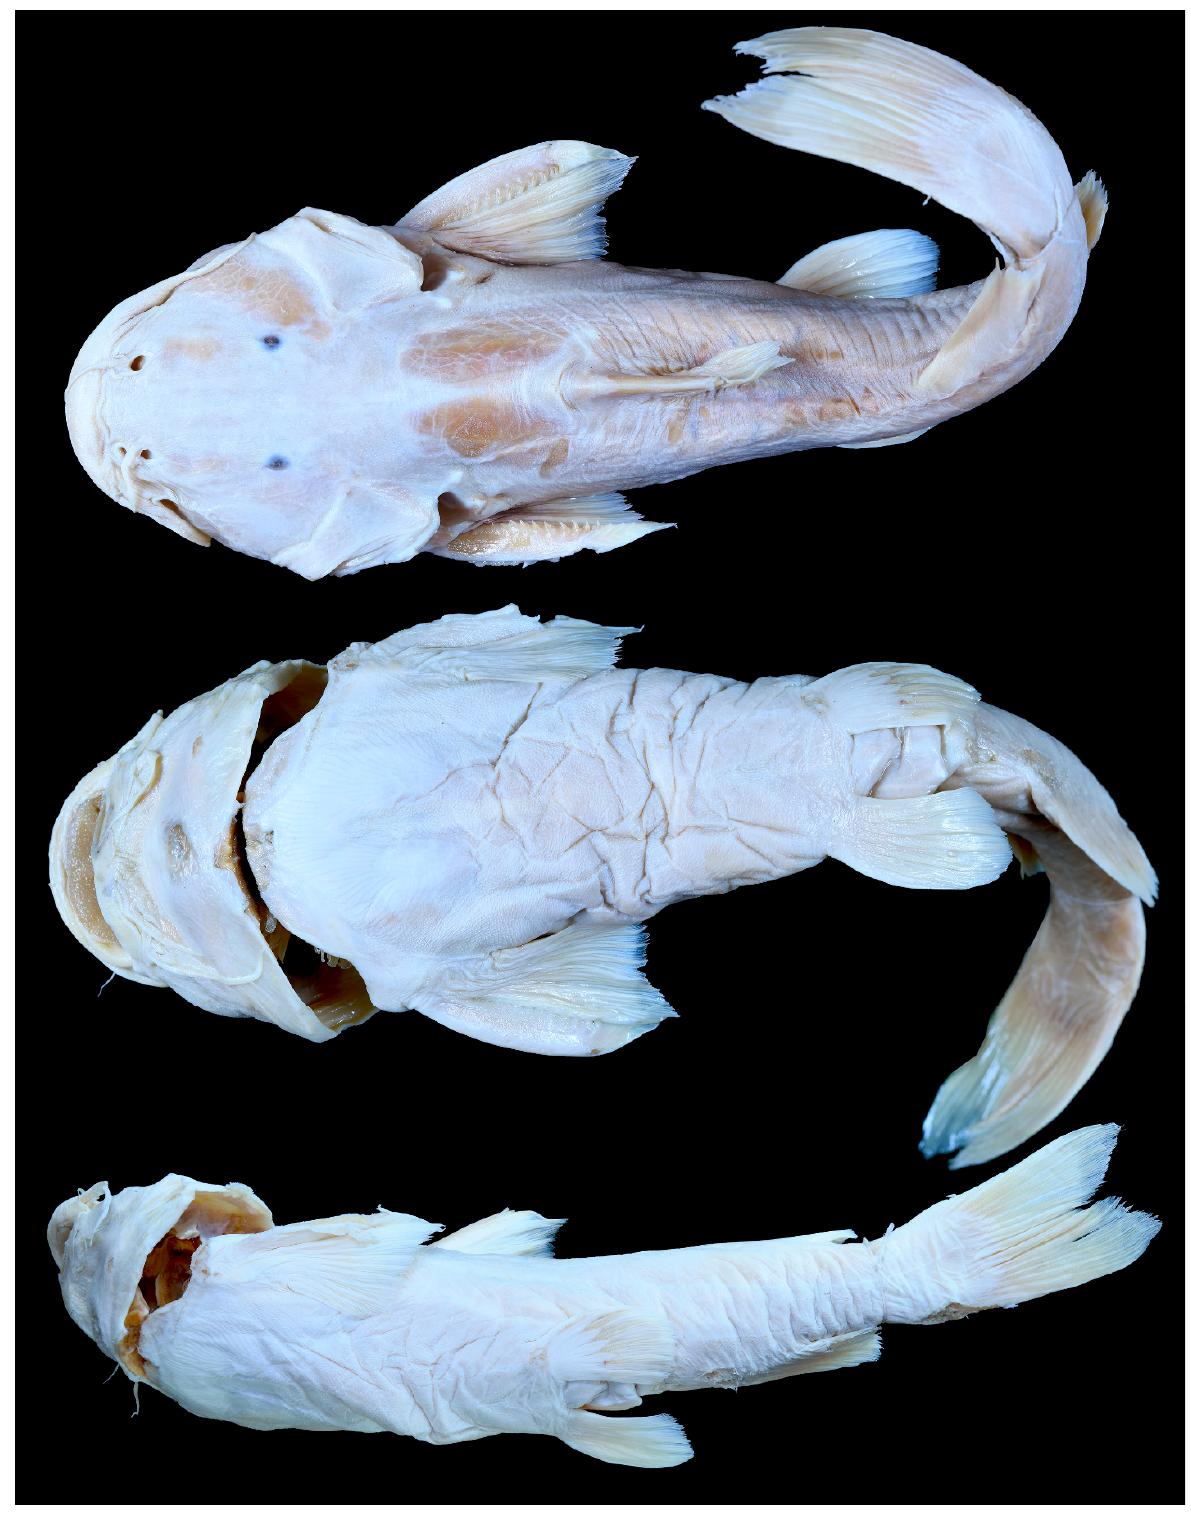
Figure 9. Glyptothorax cous , BMNH 1955.6.25.2, holotype, 243 mm SL; Syria: Qweiq at Aleppo. Copy right: The Trustees of the Natural History Museum, London.